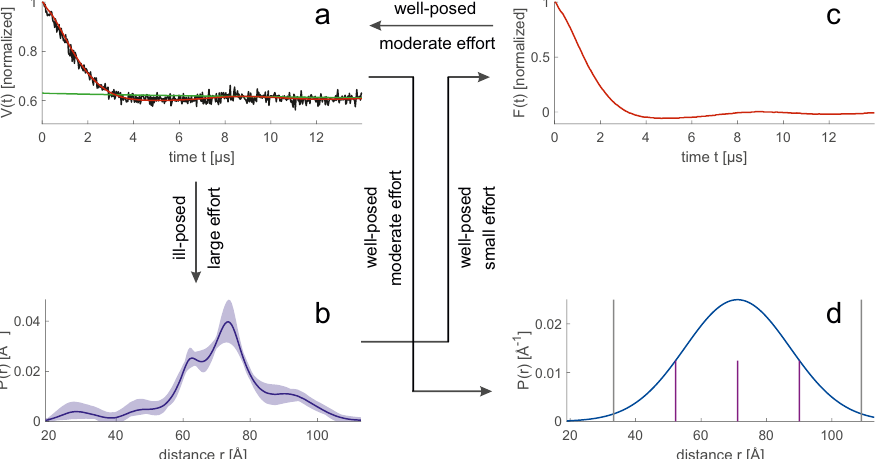
Figure 7. Different representations of a distance distribution in modelling. Data corresponds to spin-labelled site pair 202/475 in the complex of polypyrimidine tract binding protein 1 with en- cephalomyocarditis virus internal ribosome entry site [31]. Transformations between representations can be well-posed (stable) or ill-posed (potentially unstable) and may require different computational effort. ( a ) Primary DEER EPR data (black), intermolecular background (green), and fit by a distance distribution (red). ( b ) Model-free distance distribution (blue) with 95% confidence interval (pale blue). ( c ) Form factor that results from separation of the label-pair contribution from intermolecular background. The form factor is fully determined by the distance distribution. A fit to primary data involves optimisation of background parameters. ( d ) Gaussian distribution, which is fully determined by a mean value (cid:104) r (cid:105) and standard deviation σ r (blue). Grey vertical lines denote twice the full width at half maximum. Purple vertical lines denote three equidistant distance samples used for exhaustive discrete